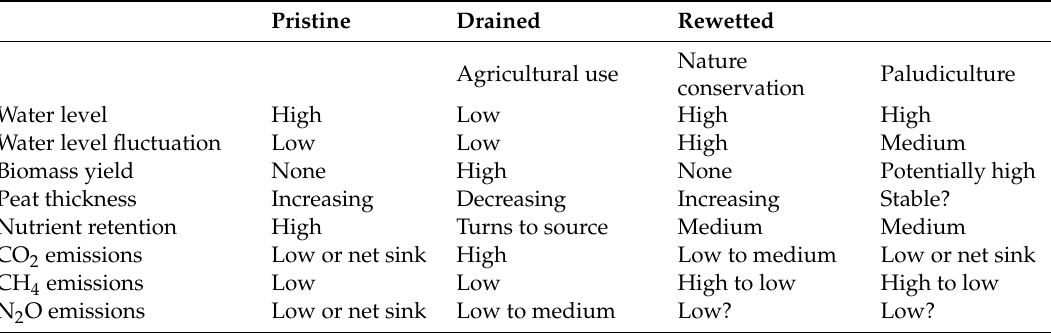
Table 1. Conceptualized characterisation of di ff erently managed fen peatlands with key unknowns marked by question marks. They were derived based on discussions among authors relying on their expertise in the di ff erent research fields. Pristine Drained Rewetted Nature Paludiculture Agricultural use conservation Water level High Low High High Water level fluctuation Low Low High Medium Biomass yield None High None Potentially high Peat thickness Increasing Decreasing Increasing Stable? Nutrient retention High Turns to source Medium Medium CO 2 emissions Low or net sink High Low to medium High to low N 2 O emissions Low or net sink Low to medium Low?